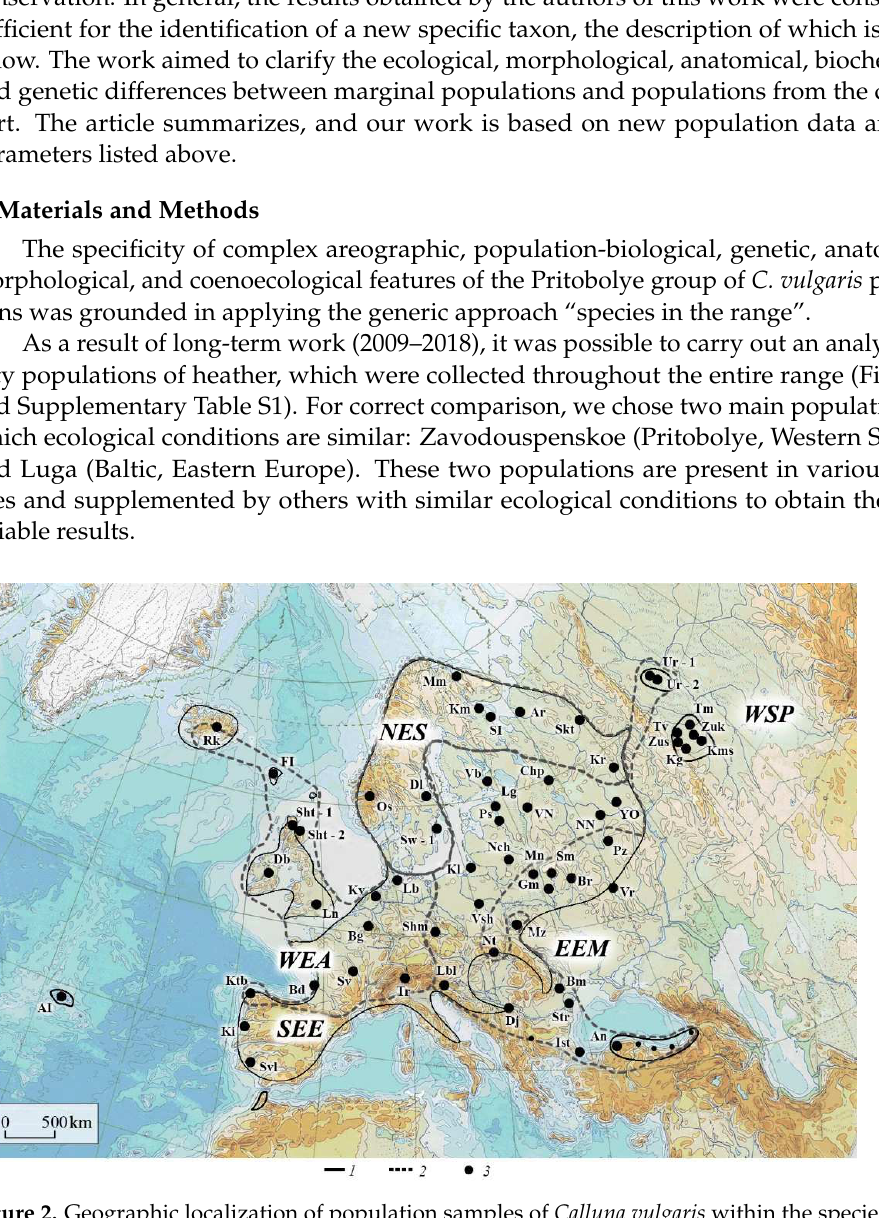
Figure 2. Geographic localization of population samples of Calluna vulgaris within the species range. 1—Range border of C. vulgaris , 2—Borders of phylogenogeographic regions, 3—Localization of C. vulgaris populations. NES—Northern-European-Scandinavian, WSP—Western-Siberian- Prito- bolye, WEA—Western-European-Atlantic, EEM—Eastern-European-Mediterranean,